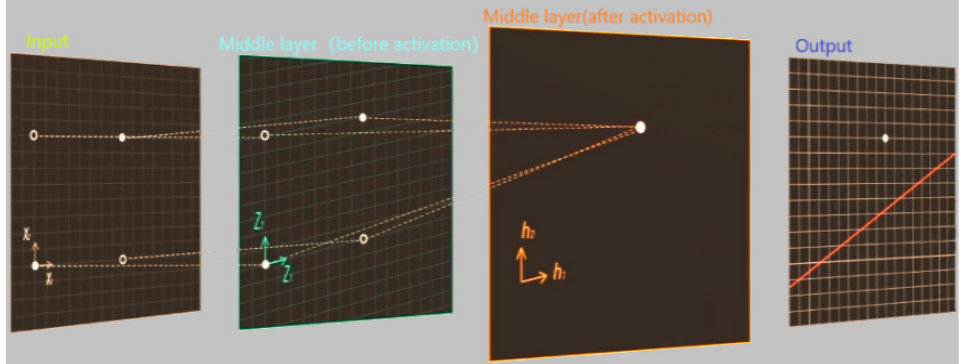
Figure 7. Planar feature mapping simulation process.